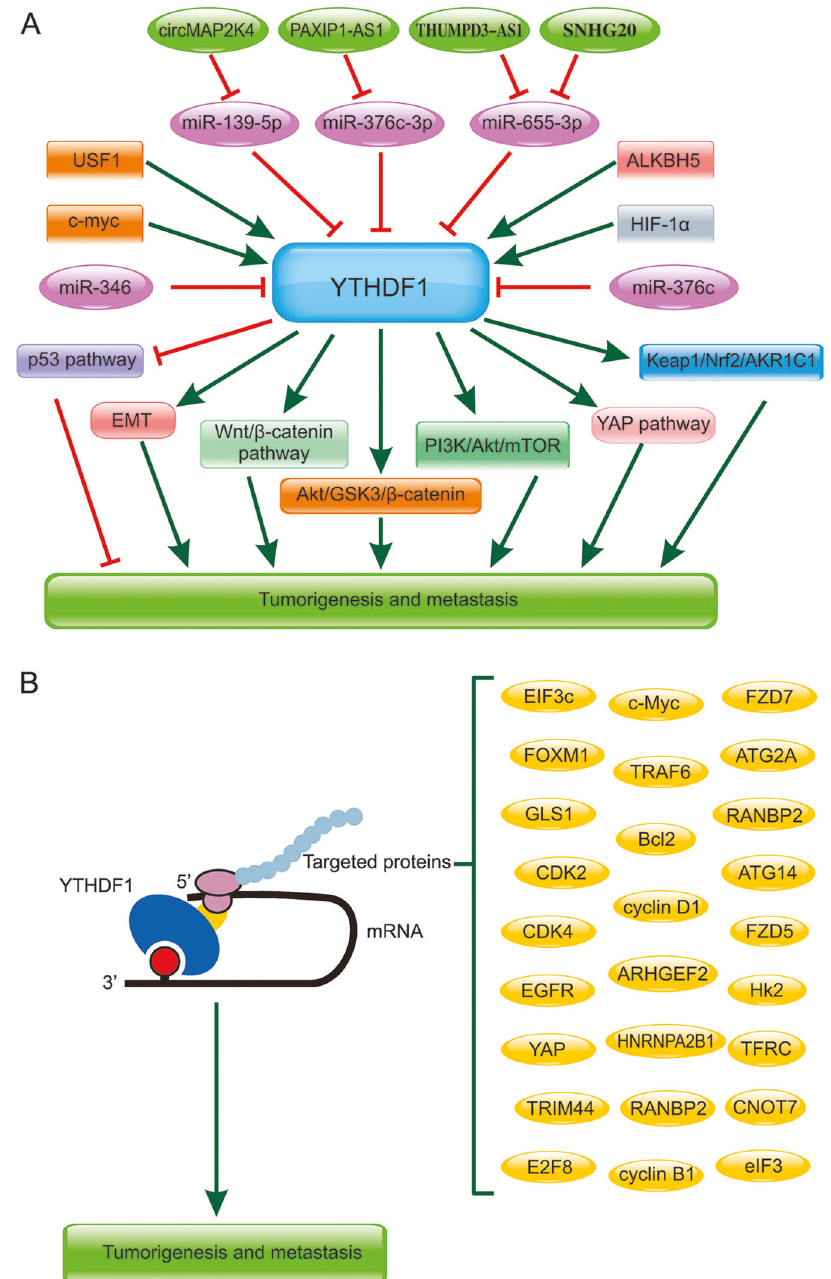
Fig. 3 The related signaling pathway on YTHDF1 in tumorigenesis and metastasis of virous cancers. A The key regulatory non-coding RNA(lncRNAs, miRNAs) and proteins were shown which were involved in YTHDF1 related signaling pathways. B The targeted proteins regulated by YTHDF1 in tumorigenesis and